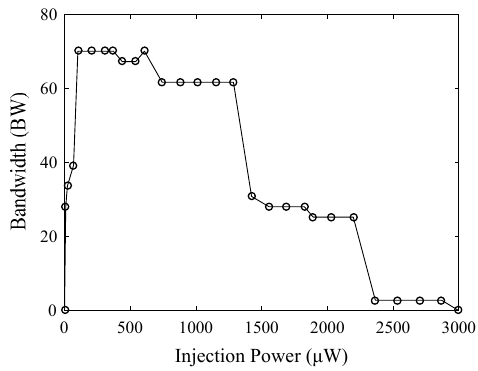
Figure 7. Evolution of the total-OFC bandwidth as a function of the injection power P i under λ i = 1553.4843 nm.